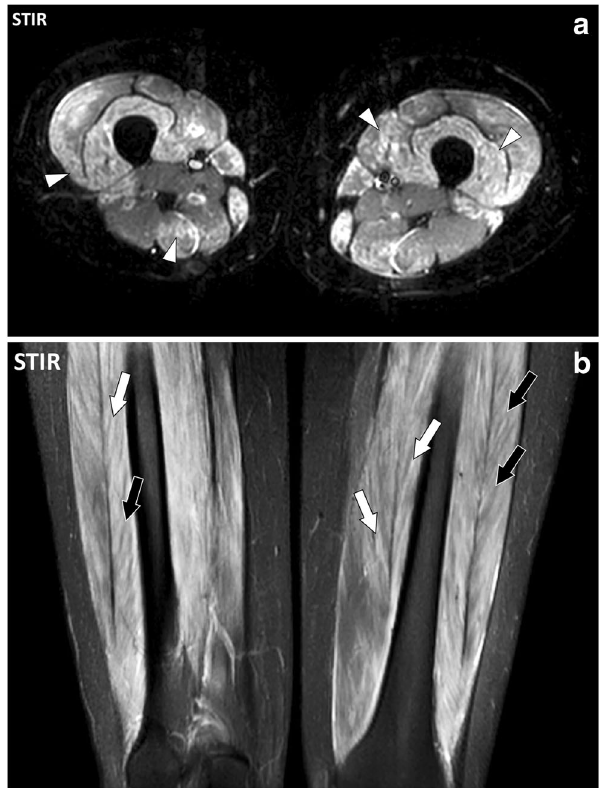
Fig. 15 a Axial and ( b ) coronal STIR images of the thighs of a 16-year- old female with dermatomyositis and anti-TIF1- γ antibodies. MRI dem- onstrates bilateral symmetrical involvement of the muscles mostly in the quadriceps and gracilis muscles. Blood level of creatine phosphokinase (CPK) was normal. At MRI, involved muscles are heterogenous with a B salt and pepper ^ pattern in the axial plane (arrowheads) while they maintain a fibrillar organization with fluid signal intensity (white arrows) and low signal intensity (black arrows) striations in the coronal plane